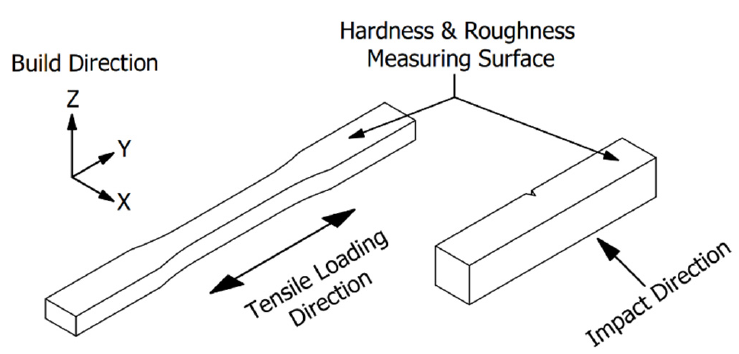
Figure 1. Building direction, testing direction, and testing surface. After LPBF printing, the as-built tensile block with thickness of 11.5 mm was